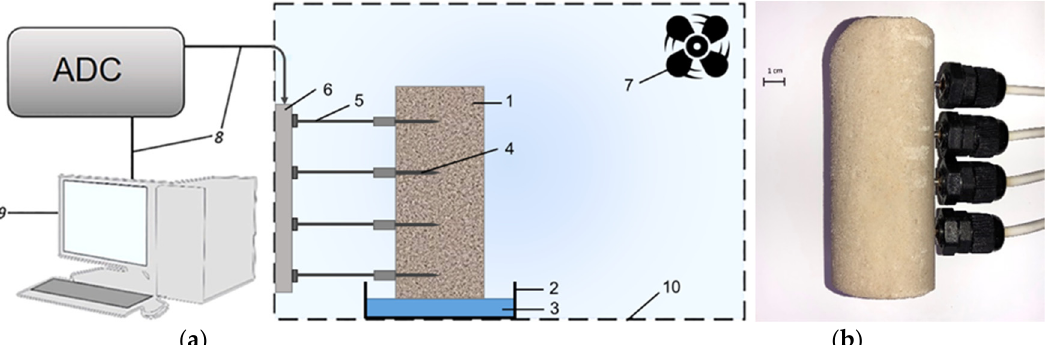
Figure 1. Sketch of Kriolab Tbf system ( a ) and picture of the frozen hydrate saturated sand sample with temperature sensors ( b ). 1 = frozen hydrate-saturated sediment; 2 = solution container; 3 = NaCl solution; 4 = temperature sensors; 5 = thermistor streamer; 6 = branch box; 7 = fan; 8 = USB cable; 9 = PC with Kriolab Tbf software; 10 = cooling chamber. Modified after [61].